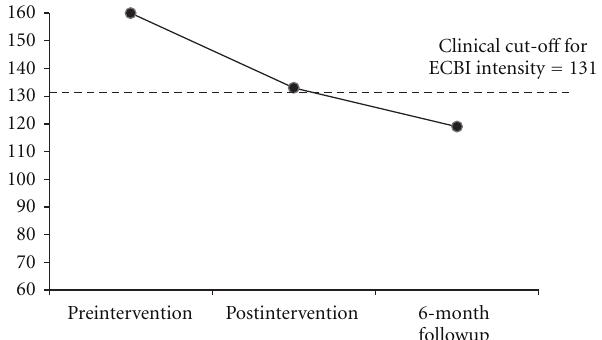
Figure 1: Change on ECBI intensity scale at preintervention, post- intervention, and 6-month